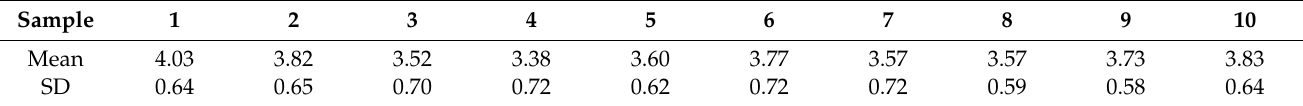
Table 15. Differences in soundscape quality assessment of 10